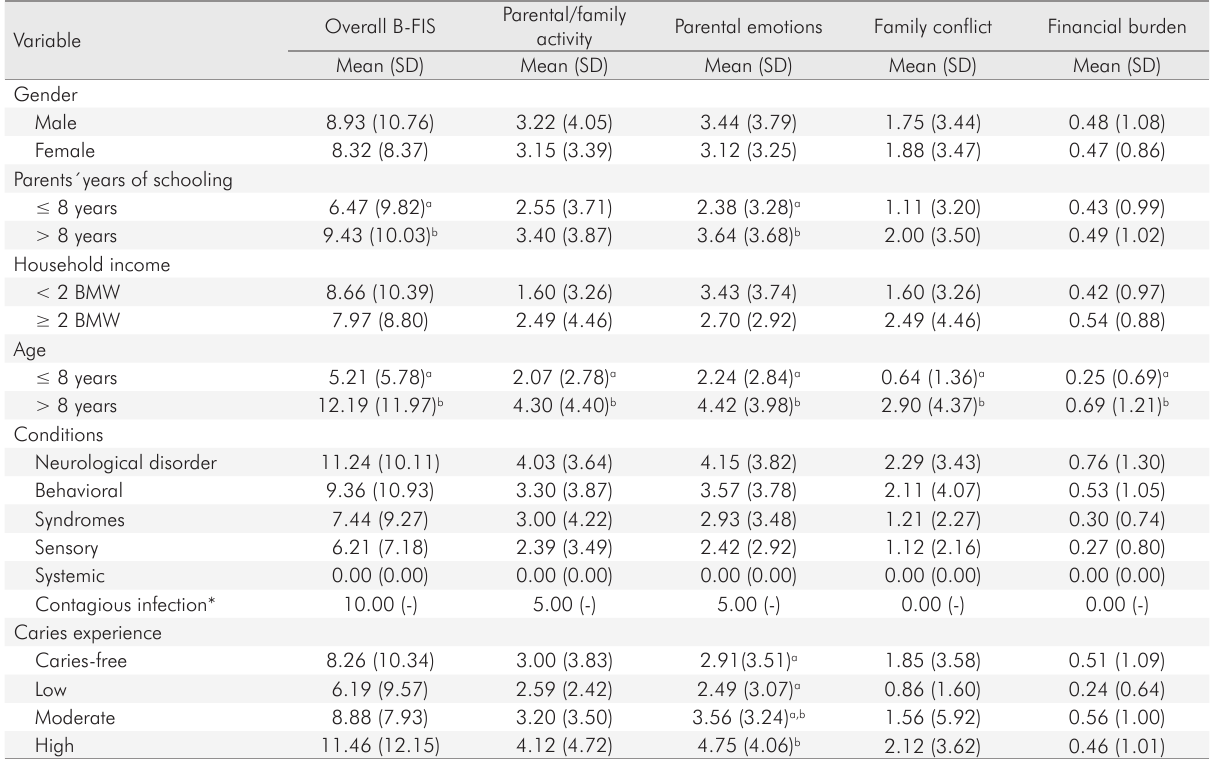
Table 2. Mean (SD) and subscale scores according to independent variables (N=227) Variable